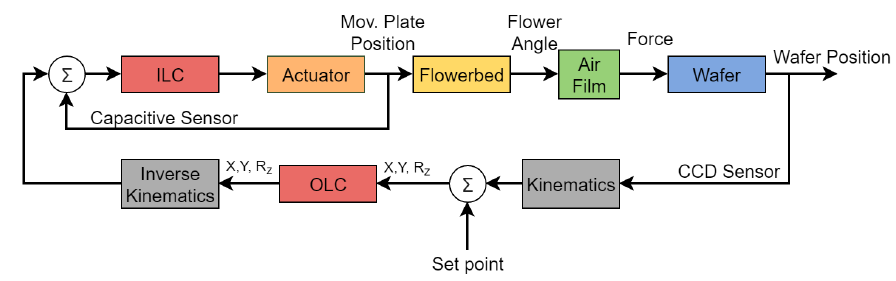
Figure 23. The control strategy for the flowerbed.